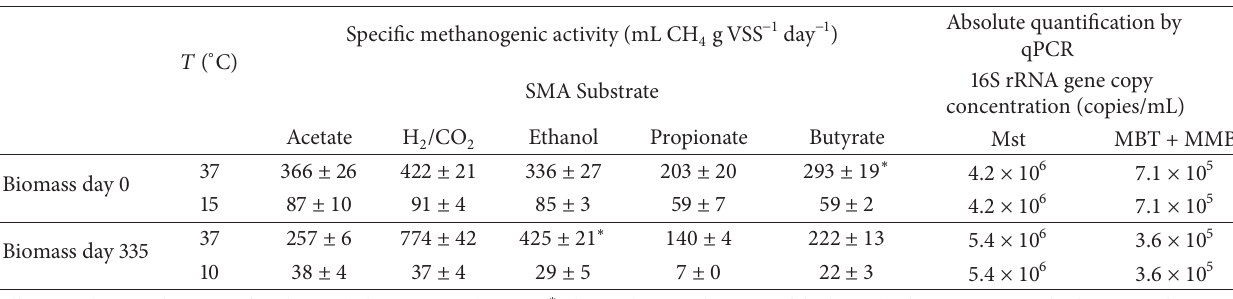
Table 2: Specific methanogenic activity (SMA) profiles against direct and indirect methanogenic substrates expressed as mL CH day − 1 and the absolute quantification of 16S rRNA gene copy concentration expressed in copies/mL, of day 0 and day 335 biomass.